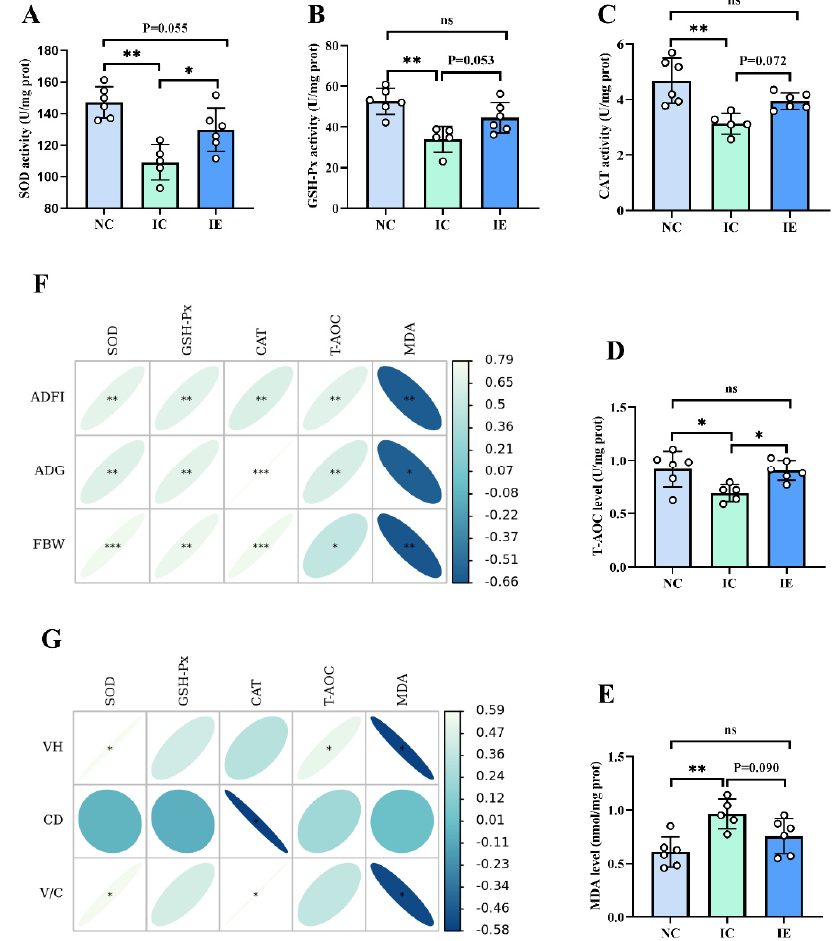
Figure 3. Effects of EGF on the intestinal antioxidant capacity of piglets with IUGR. ( A ) SOD, ( B ) GSH-Px, ( C ) CAT, ( D ) T-AOC, ( E ) MDA, ( F ) correlation analysis between intestinal antioxidant capacity and growth performance, ( G ) correlation analysis between intestinal antioxidant capacity and intestinal morphology. Values are expressed as means ± SEM, n = 6 (1 pig in the IC group was dead, n = 5 in the IC group); NC: NBW piglets fed with basal diet; IC: IUGR piglets fed with basal diet; IE: IUGR piglets fed with basal diet supplemented with 2 mg/kg EGF. * p < 0.05, ** p < 0.01, *** p < 0.001.